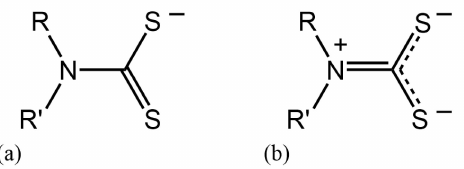
Figure 1. Chemical diagrams for ( a ) the dithiocarbamate anion and ( b ) the dithiolate canonical form. R, R’ = H, alkyl, and